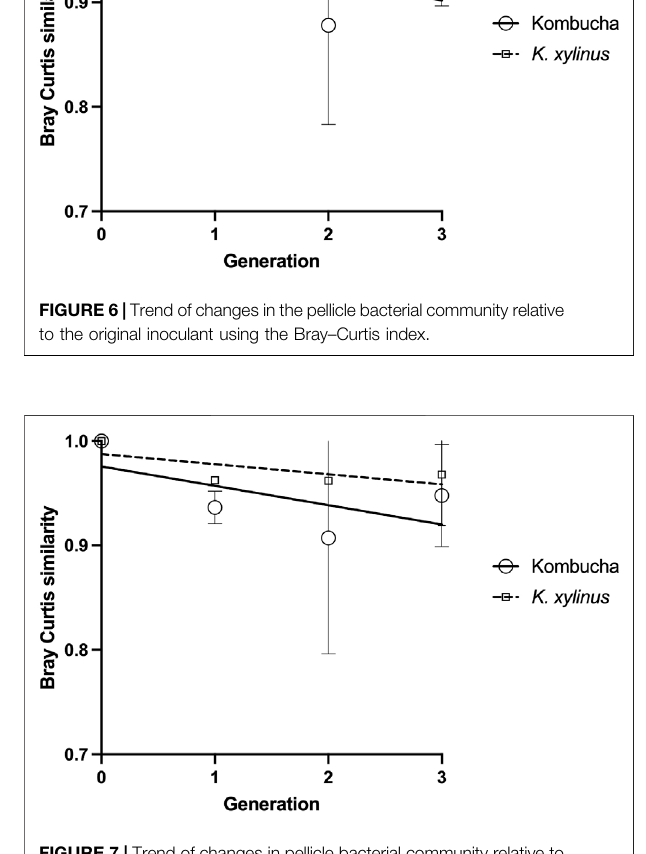
FIGURE 7 | Trend of changes in pellicle bacterial community relative to previous generation using the Bray – Curtis